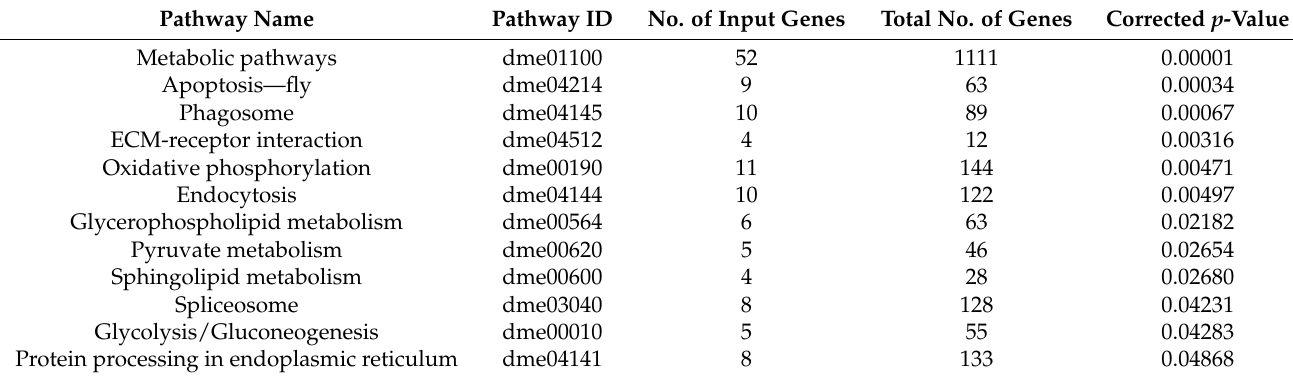
Table 4. Enriched KEGG pathways detected in the DETs identified by the RNA-Seq meta-analysis of Chinese mitten crab (CMC) gills under